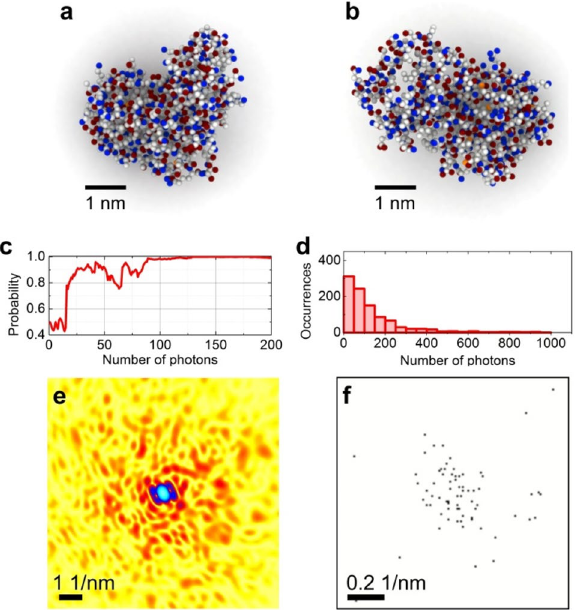
Figure 4. Structure verification of a single lysozyme molecule from a low-dose X-ray diffraction pattern. ( a ) and ( b ) structure of the molecule in xy - and xz -orientation, respectively. ( c ) Probability of the right hypothesis ( xy -orientation) as a function of the number of detected photons. ( d ) Number of photons required to achieve 95% probability that the sample structure hypothesis is correct; results of 1000 experiments are shown. (e) and (f) X-ray diffraction patterns of a lysozyme molecule formed by elastically scattered (e) 1.24E + 8 photons/ Å 2 and ( f ) 0.11 photons/Å 2 (f). In ( e ), the full, 1024 × 1024 pixel diffraction pattern is shown, the maximum is 8.0E + 7 counts per pixel (cpp). In ( f ), only the central 128 × 128 pixel region of 1024 × 1024 diffraction pattern is shown, with the maximum of 1